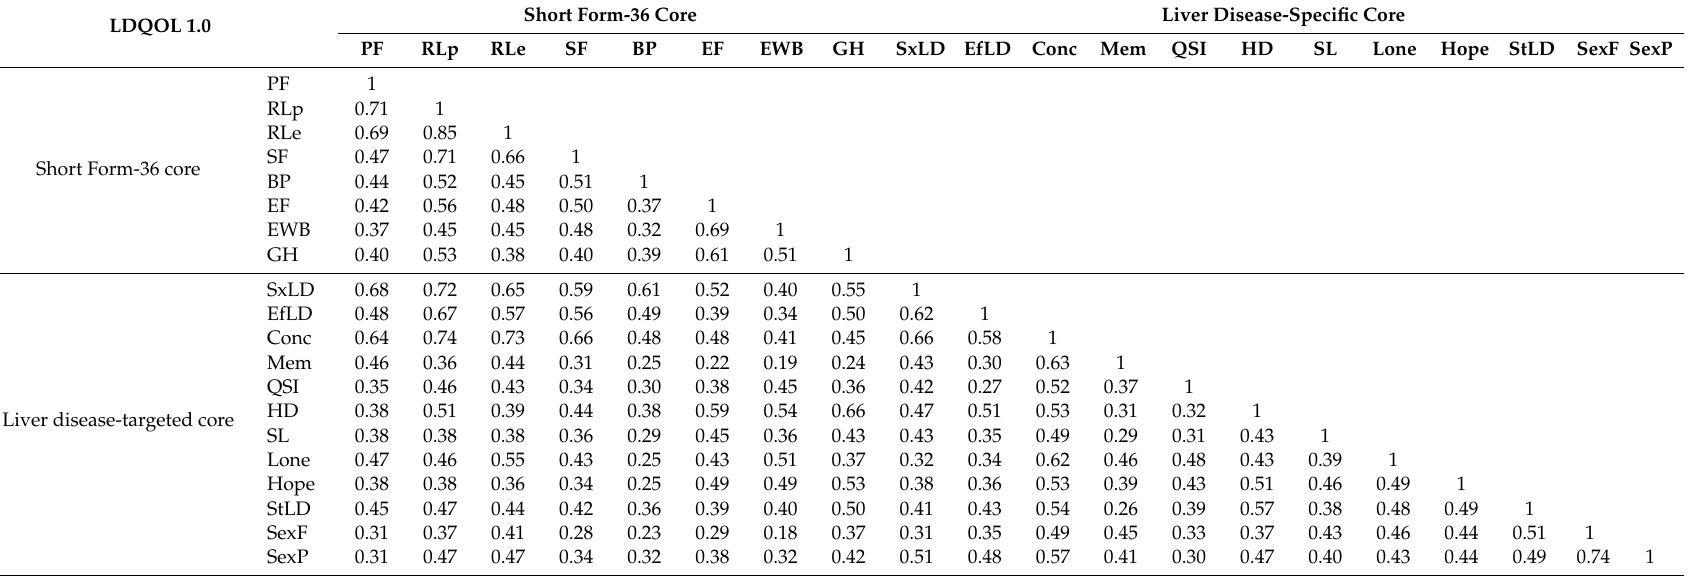
Table 3. LDQOL 1.0 product-moment correlation coe ffi